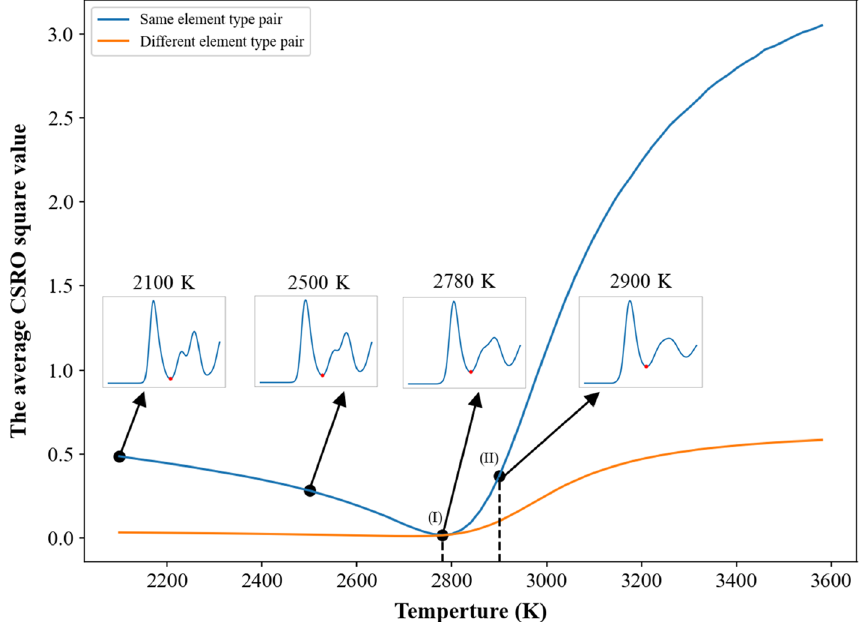
Figure 12. Average CSRO square profiles of the same and different element type pairs for the Nb